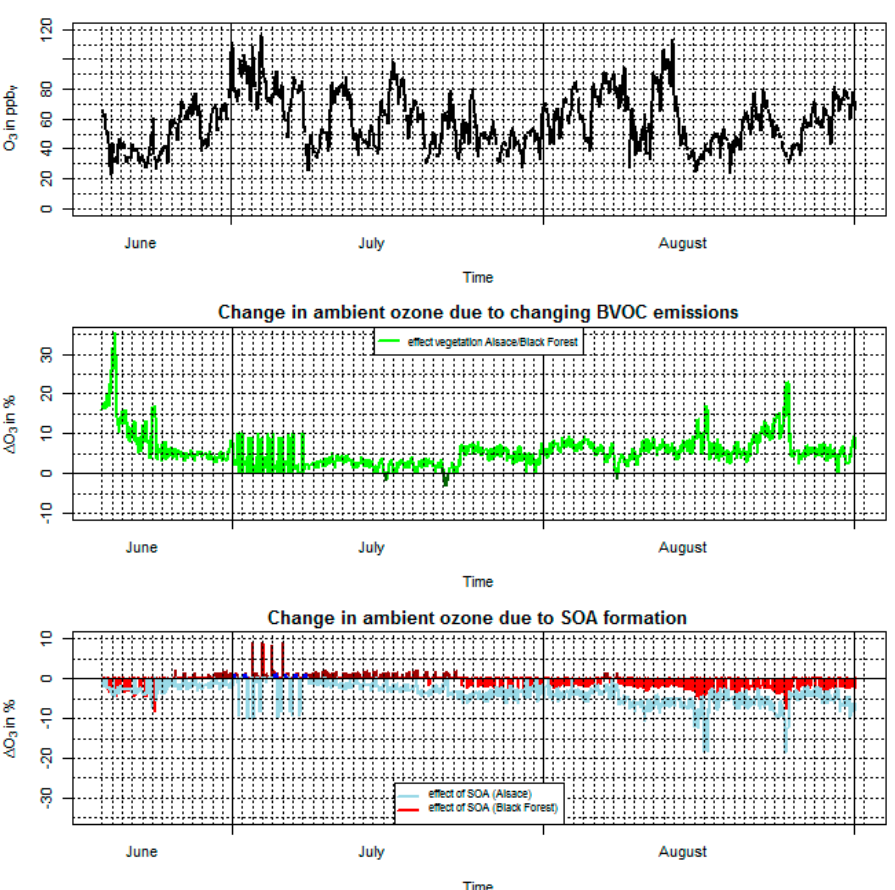
Figure 4. Summertime tropospheric (ground level) ozone mixing ratio: Observations in the Black Forest ( top ), effect of changing tree species contributions ( middle ) and of secondary organic aerosol ( bottom